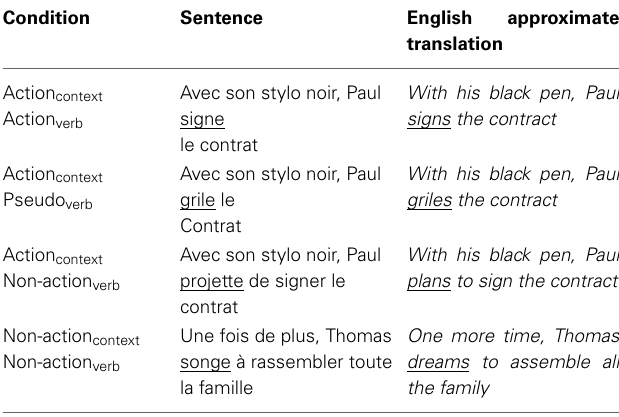
Underlined words represent the target